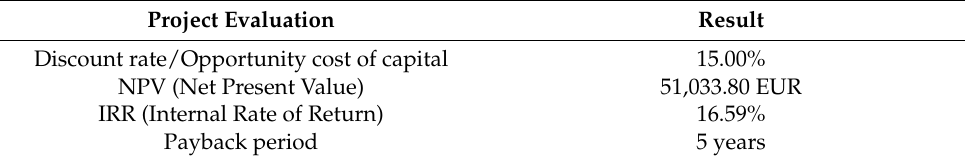
Table 9. Evaluation of the investment project—Scenario